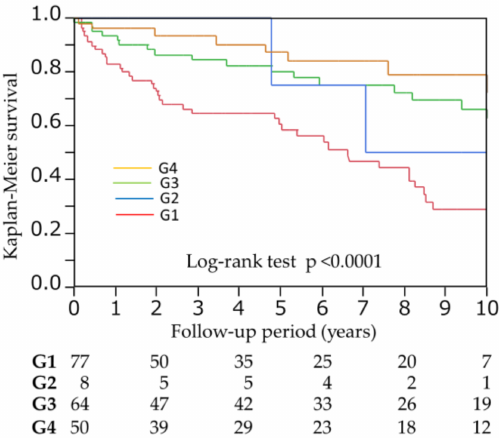
Figure 1. Meier survival curves for all-cause mortality among divided four groups according to each cutoff point of VFA and SFA, which predict mortality. G1: VFA < 78.7 cm 2 , SFA < 93.2 cm 2 ; G2: VFA ≥ 78.7 cm 2 , SFA < 93.2 cm 2 ; G3: VFA < 78.7 cm 2 , SFA ≥ 93.2 cm 2 ; G4: VFA ≥ 78.7 cm 2 ,